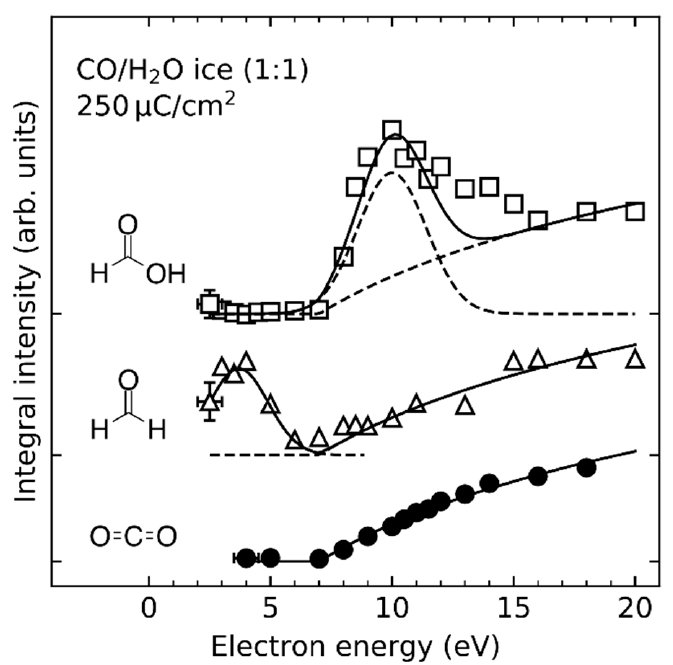
Figure 20. Dependence of the integrated desorption intensities of the m / z 45 signal of formic acid (HCOOH, ), the m / z 30 signal of H 2 CO ( (cid:97) ), and of the m / z 44 signal of CO 2 ( • ) on electron energy (cid:31) obtained by TDS after irradiation of CO/H 2 O (1:1) mixed ices with 250 µ C/cm 2 . Individual curves are scaled by an arbitrary factor to facilitate comparison. The solid and broken lines serve as a guide to the eye. Adapted with permission from Ref. [24]. Copyright 2019 American Chemical Society.